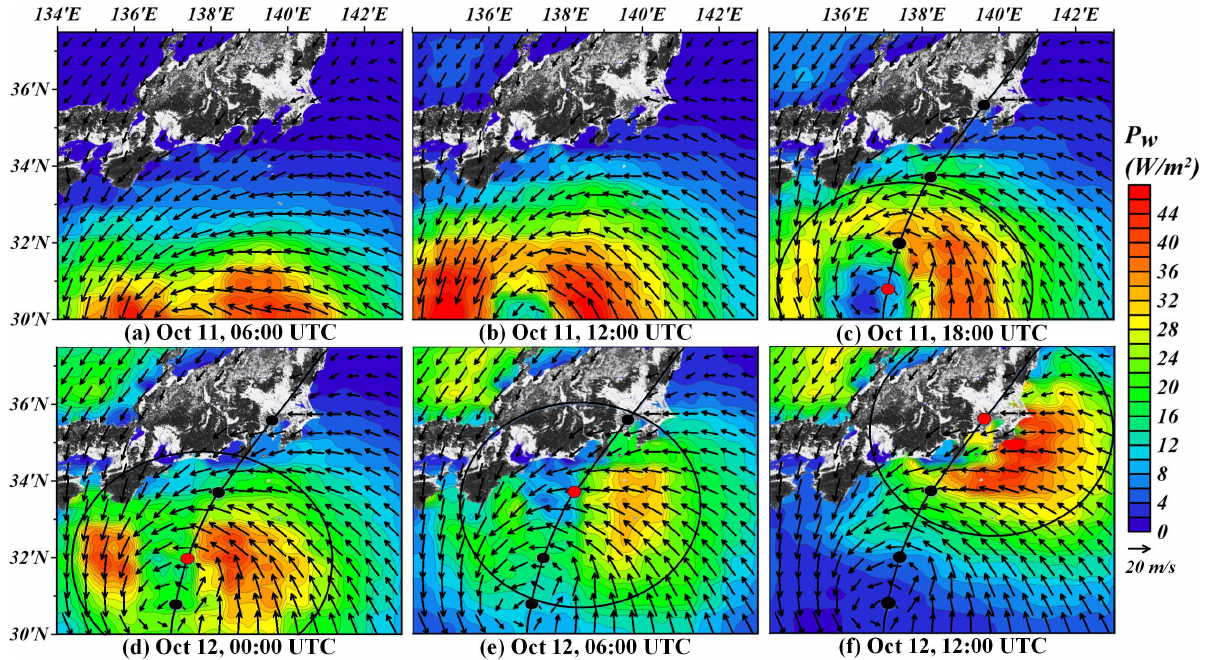
Figure 4. Spatial distribution of Ekman pumping velocity (EPV; × 10 − 5 m/s) with wind stress vectors (black arrows) provided by CMEMS, storm wind zones (black circles), and the typhoon track with the intensity (black line; red dots) obtained by JMA; ( a ) 11 October, 06UTC, ( b ) 12UTC ( c ) 18UTC, ( d ) 12 October, 00UTC ( e ) 06UTC, and ( f ) 12UTC,